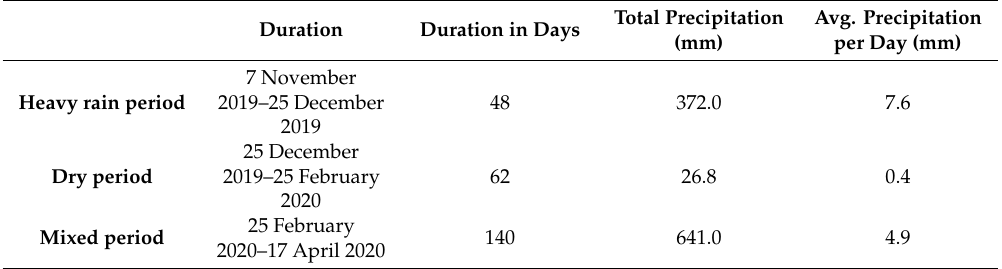
Table 4. Basic weather conditions during the observation period (7 November 2019–14 July